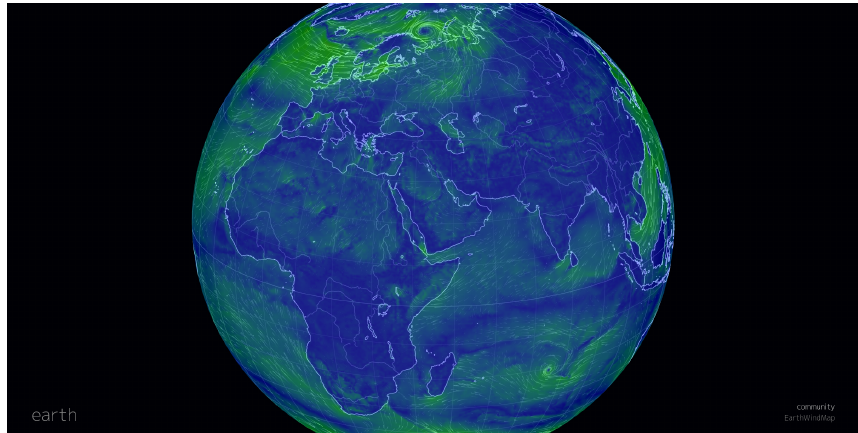
Figure 8. A screen capture, taken 20 March 2020, of earth , an animated virtual globe by Cameron Beccario (available at https://earth.nullschool.net/). Interaction reveals a menu wherein users can select for various atmospheric and oceanographic data themes. The map uses thousands of little animated strokes in flock-like motion to illustrate dynamic Earth processes, such as wind patterns.